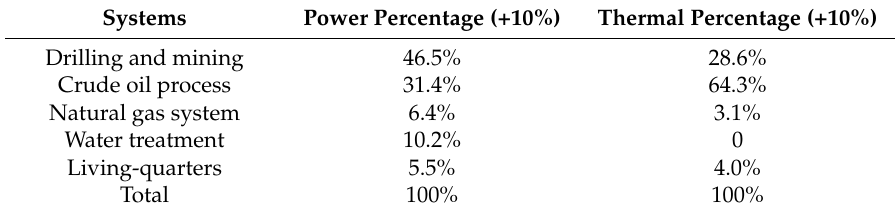
Table 5. Proportions of electricity and heat consumed by five subsystems of the offshore platform OEPS.